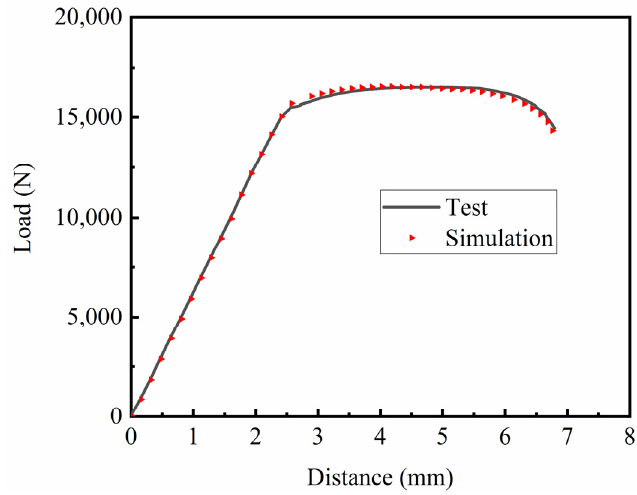
Figure 8. Comparison of the load–displacement curves of smooth specimens.